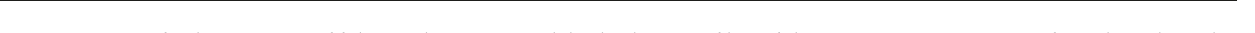
Fig. 5 p53 is necessary for the emergence of failing cardiomyocytes and the development of heart failure. a Representative images of an echocardiographic assessment of p53 fl ox/ fl ox (p53 f/f ) and p53CKO mice before and after TAC (weeks 2 and 4). b Bar plots showing body weight, cardiac size, and cardiac function evaluated by echocardiography in p53 f/f and p53CKO mice before and after pressure overload. Mean and standard error of the mean are shown ( n = 12 [p53 f/f ] and 15 [p53CKO] for pre-TAC, 11 [p53 f/f ] and 10 [p53CKO] for post-TAC W2, and 7 [p53 f/f ] and 7 [p53CKO] for post-TAC W4). Asterisks indicate statistical signi fi cance ( P <0.05, two-tailed unpaired t -test). c Violin plot showing the distribution of the correlation coef fi cients of single-cell transcriptomes among cardiomyocytes from p53 f/f and p53CKO mice at 2 weeks after TAC (43 p53 fl ox/ fl ox and 34 p53CKO cardiomyocytes). d Unsupervised hierarchical clustering classifying cardiomyocytes (p53 f/f and p53CKO cardiomyocytes [TAC W2]) into four cell clusters (cell clusters A – D). Colored bars below the heatmap indicate the cell sources (p53 f/f [red] or p53CKO [cyan]) and the cell clusters (A – D). e t-SNE plots of cardiomyocytes from p53 f/f and p53CKO mice at 2 weeks after TAC. Cells (dots) are colored by the cell sources (left) and according to the cell clusters in d (right). f t-SNE plots colored by the expression of each module. g Scatter plots showing the expression of M1 and M3 (left) and M3 and M24 (right) in cardiomyocytes from p53 f/f and p53CKO mice. h Bar plot showing the distribution of allocated cardiomyocytes from p53 f/f and p53CKO mice (TAC W2). i Violin plot showing the distribution of the correlation coef fi cients of single-cell transcriptomes among cardiomyocytes from p53 f/f and p53CKO mice (TAC